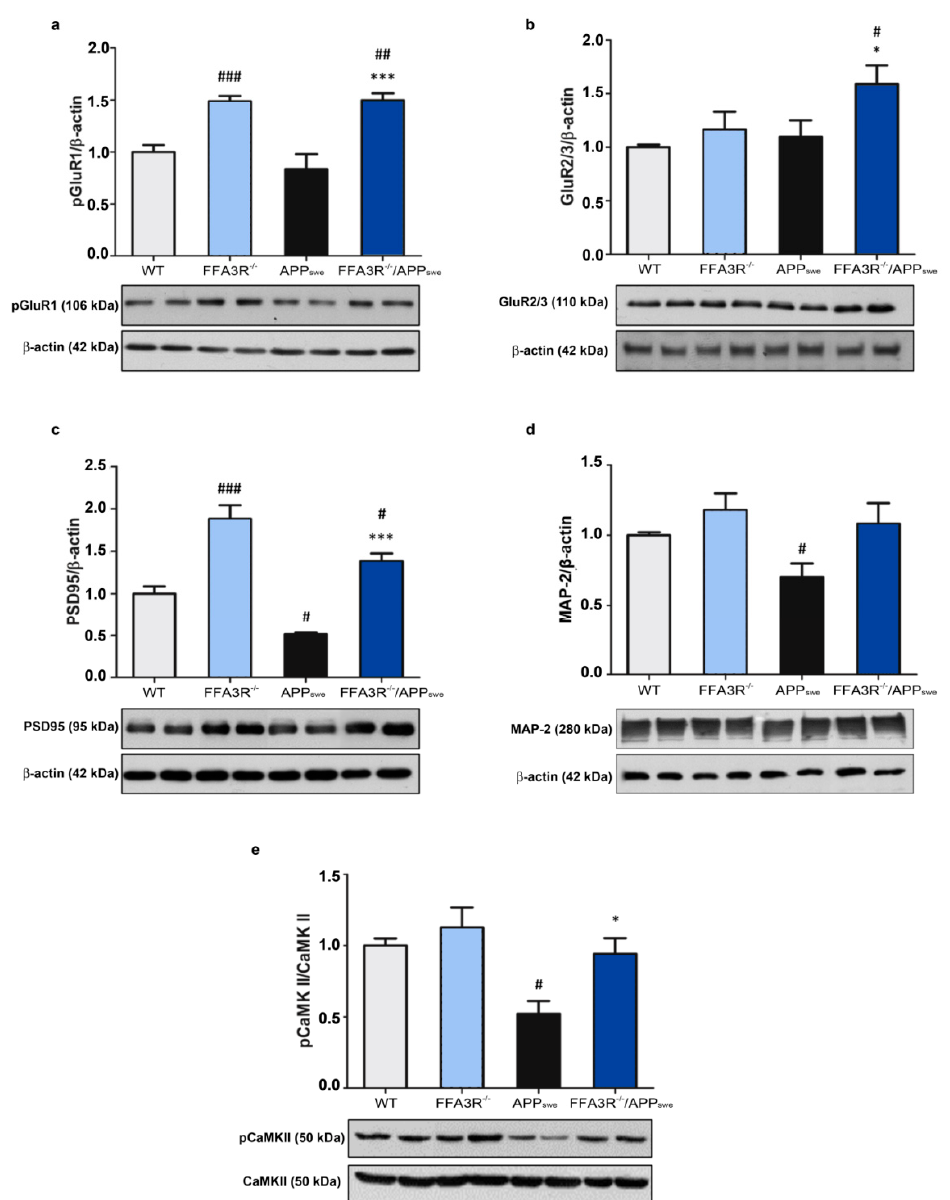
Figure 8. Synaptic plasticity markers are restored in the FFA3R − / − /APP swe mice. The levels of synaptic markers in membrane cortex extracts of WT, FFA3R − / − , APP swe , and FFA3R − / − /APP swe mice were analyzed by Western blot. We show a representative blot and the quantification of immunoreactive bands for each protein. The results are expressed as the mean ± SEM (n = 6) normalized to the ratio of WT mice. ( a ) AMPA subunit pGLuR1 vs β -actin. ( b ) AMPA subunit GluR2/3 vs. β -actin. ( c ) Cytoskeletal protein PSD95 vs. β -actin. ( d ) Microtubule-associated protein MAP-2 vs. β -actin. ( e ) Phosphorylated LTP mediator CaMK II vs. CaMK II. # p < 0.05, ## p < 0.01, ### p < 0.001 vs. WT. * p < 0.05, *** p < 0.001 vs. APP swe .